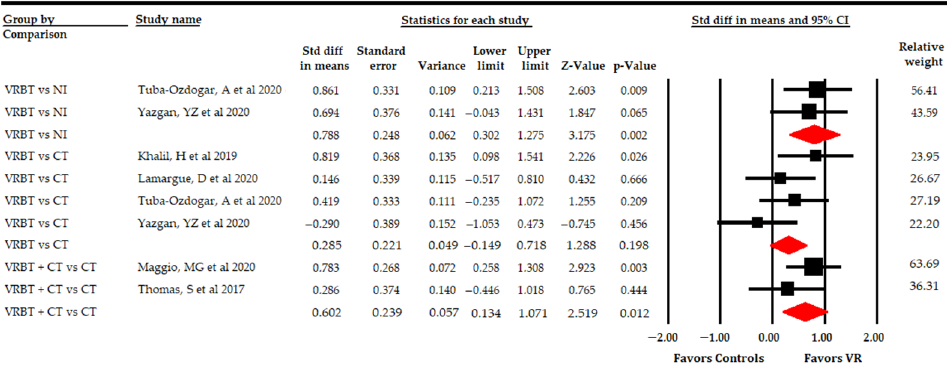
Figure 7. Subgroup Analysis of the Effect of Virtual Reality on Overall Quality of Life According to Specific Comparisons.